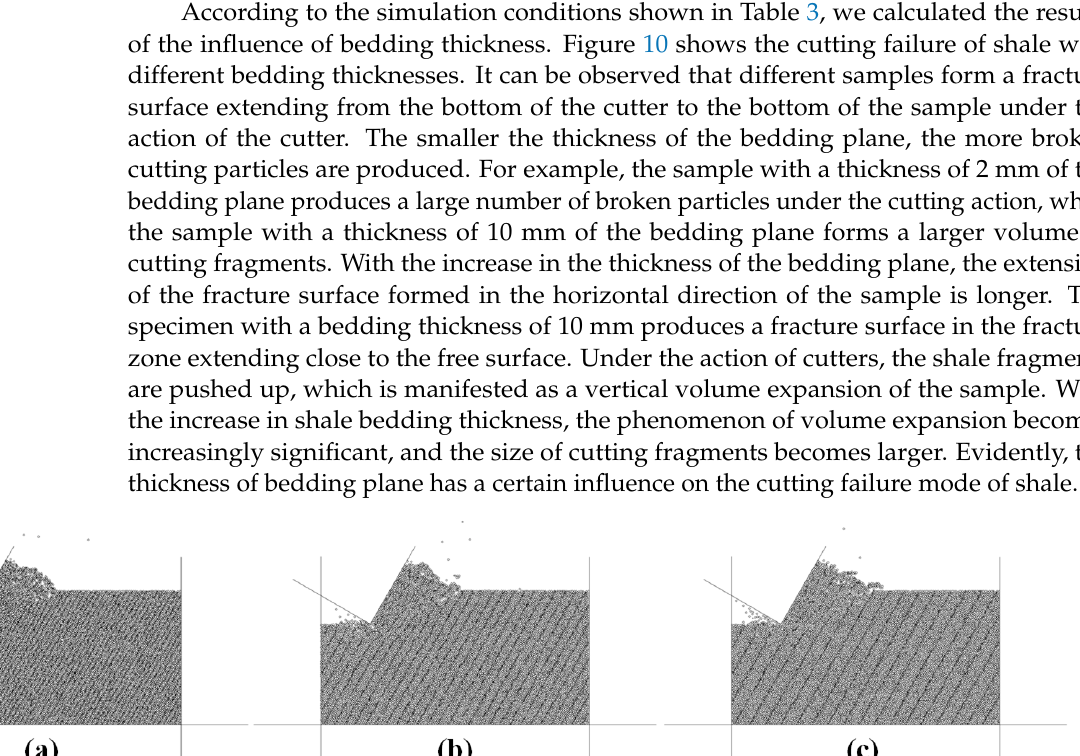
11 of 30 Figure 9. Variation characteristics of crack number of samples with different bedding dips: ( a ) 0°;